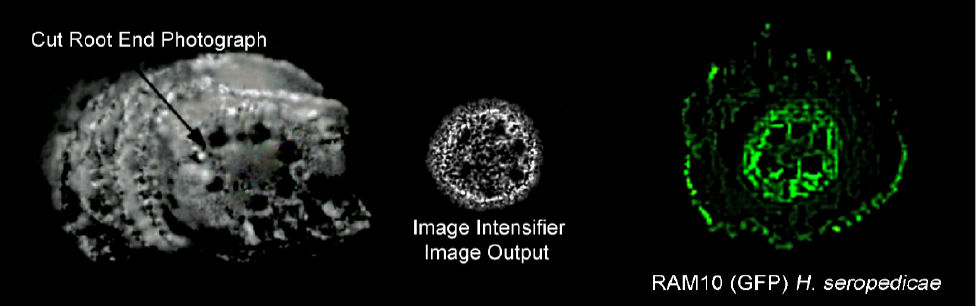
Figure 6. The macrophotograph of the cut root end shows xylem vasculature (darkened regions) in the center core. In the center is an image of the intensifier output of light showing higher light transmission in the endodermal ring surrounding the inner vascular core. The green fluorescence image on the right side was adapted from our prior studies using a GFP reporting strain of H. seropedicae [27] to identify regions within root transections that showed high levels of microbial colonization.